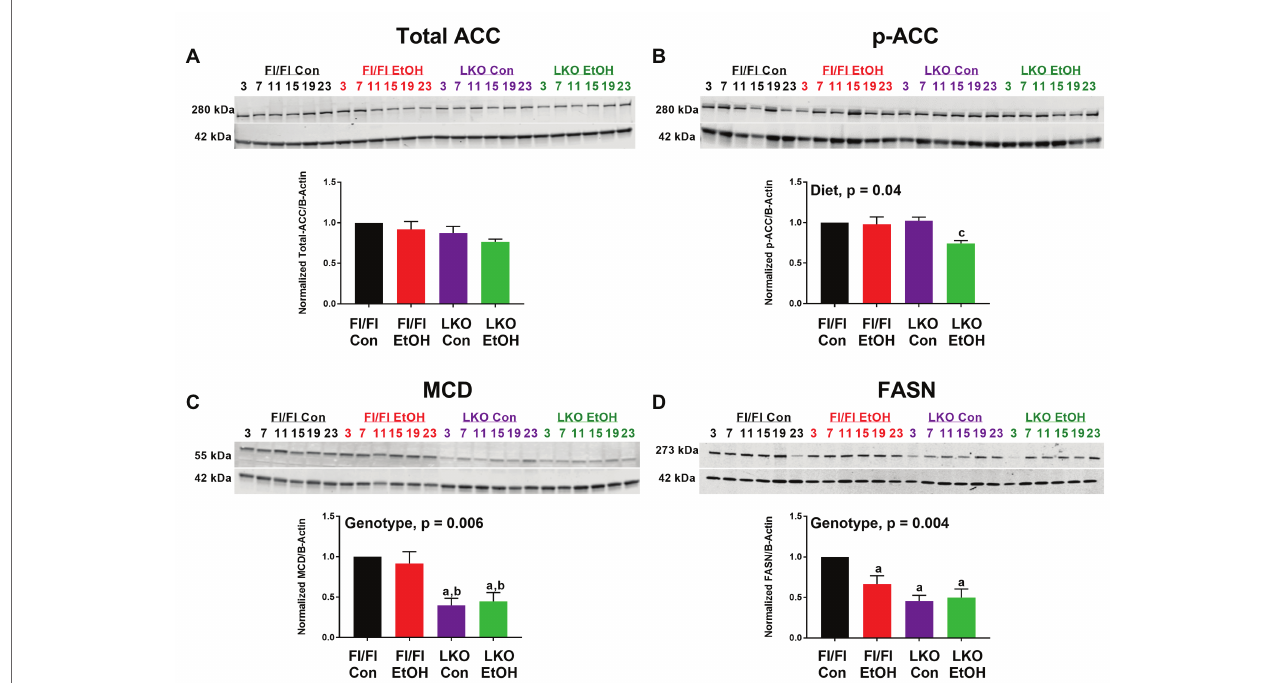
FIGURE 6 | Chronic alcohol and liver clock disruption alter abundance and phosphorylation state of select fatty acid metabolism proteins. Diurnal protein abundances of total acetyl CoA carboxylase (Total ACC; A ), phosphorylated acetyl CoA carboxylase (p-ACC; B ), malonyl-CoA decarboxylase (MCD; C ), and fatty acid synthase (FASN; D ) were determined by western blotting using liver homogenates of control-fed (black) and alcohol-fed (red) Bmal1 Flox/Flox (Fl/Fl) and control-fed (purple) and alcohol-fed (green) Bmal1 liver-specific knockout (LKO) mice from ZT 3, 7, 11, 15, 19, and 23 (ZT 0: lights on/inactive period, ZT 12: lights off/active period). Protein abundances were detected using the LI-COR Odyssey ® digital imaging system. A representative image is presented for each protein of interest showing a full time course. The bar graphs indicate the average protein abundance calculated over the 24 h day normalized to β -actin, and levels are displayed as a fold-change from the control-fed Fl/Fl group. Data are shown as mean ± SEM n = 3–4 mice/genotype/diet. Significant two-factor ANOVA results are included in graphs. Letters indicate statistically significant differences ( p < 0.05) for comparisons to control-fed Fl/Fl mice (a), alcohol-fed Fl/Fl mice (b), and control-fed LKO mice (c).